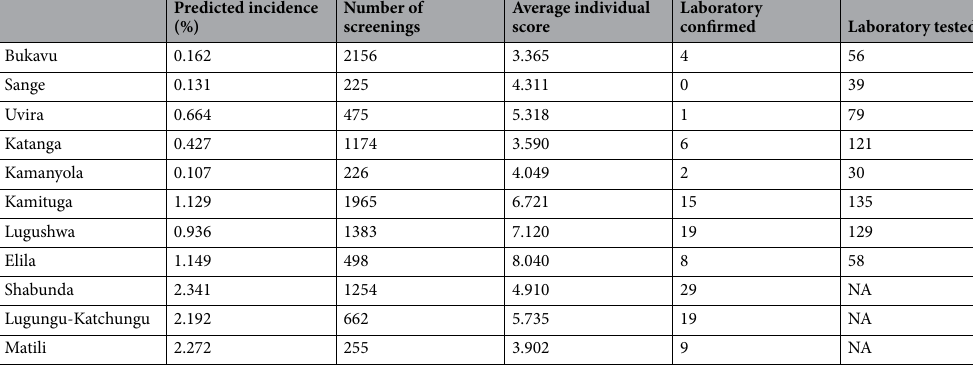
Table 1. Project statistics disaggregated by